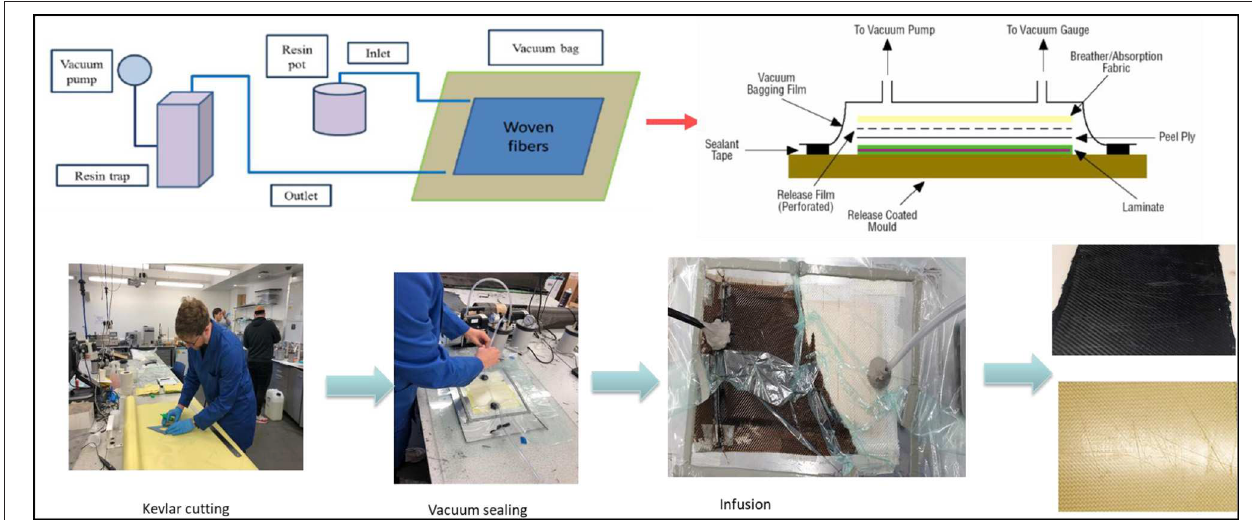
FIGURE 6 | Illustration of composite construction process utilizing GO as